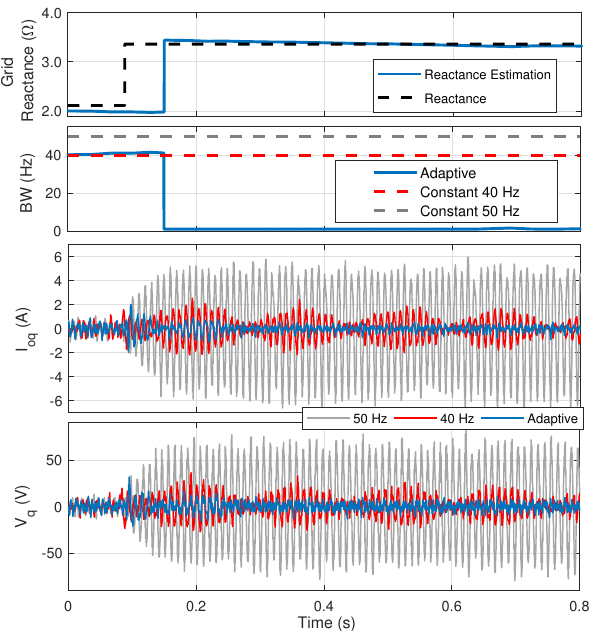
Figure 13. Performance comparison of adaptive PLL and conventional high-bandwidth PLLs in weak